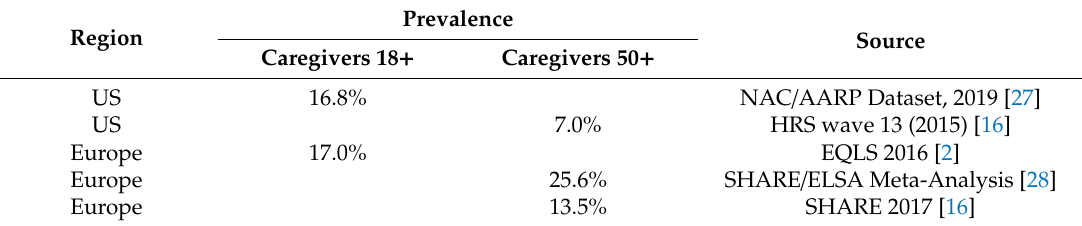
Table 1. Mean prevalences of informal caregivers in international surveys.